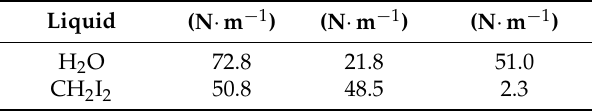
Table 1. Surface tension data of selected examined